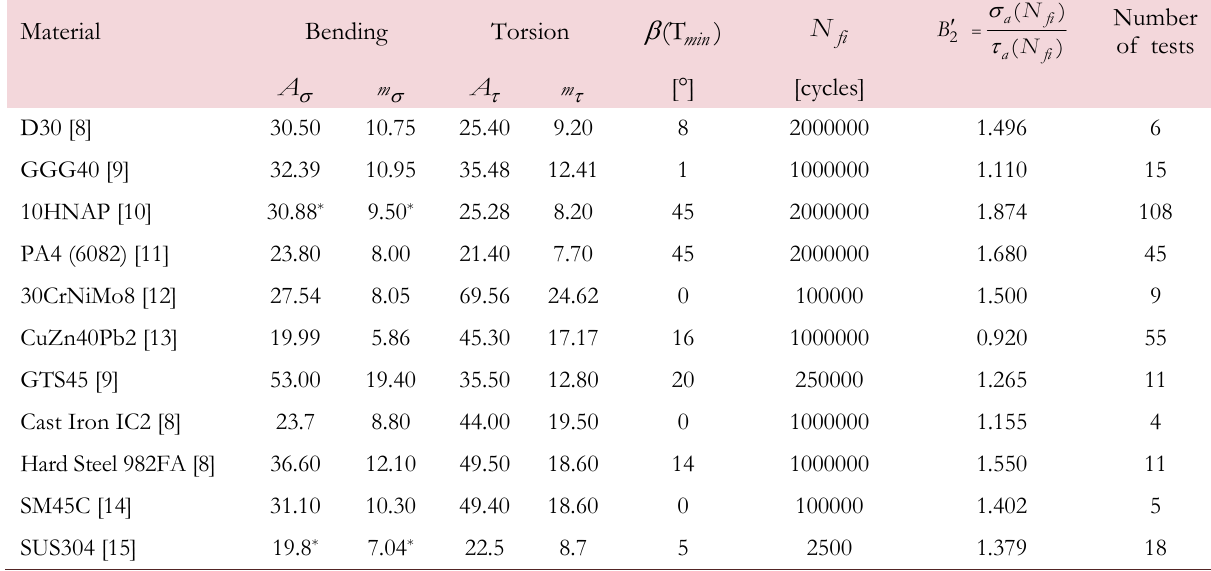
Table 1: Coefficients of regression Eqs. (14) and (15) and fatigue properties of the examined materials. The number of tests is also